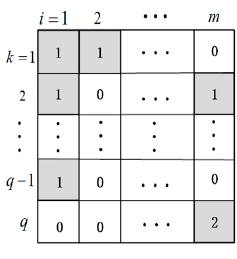
Figure 6. 2D accumulation coding for a channel allocation scheme (Case 1).